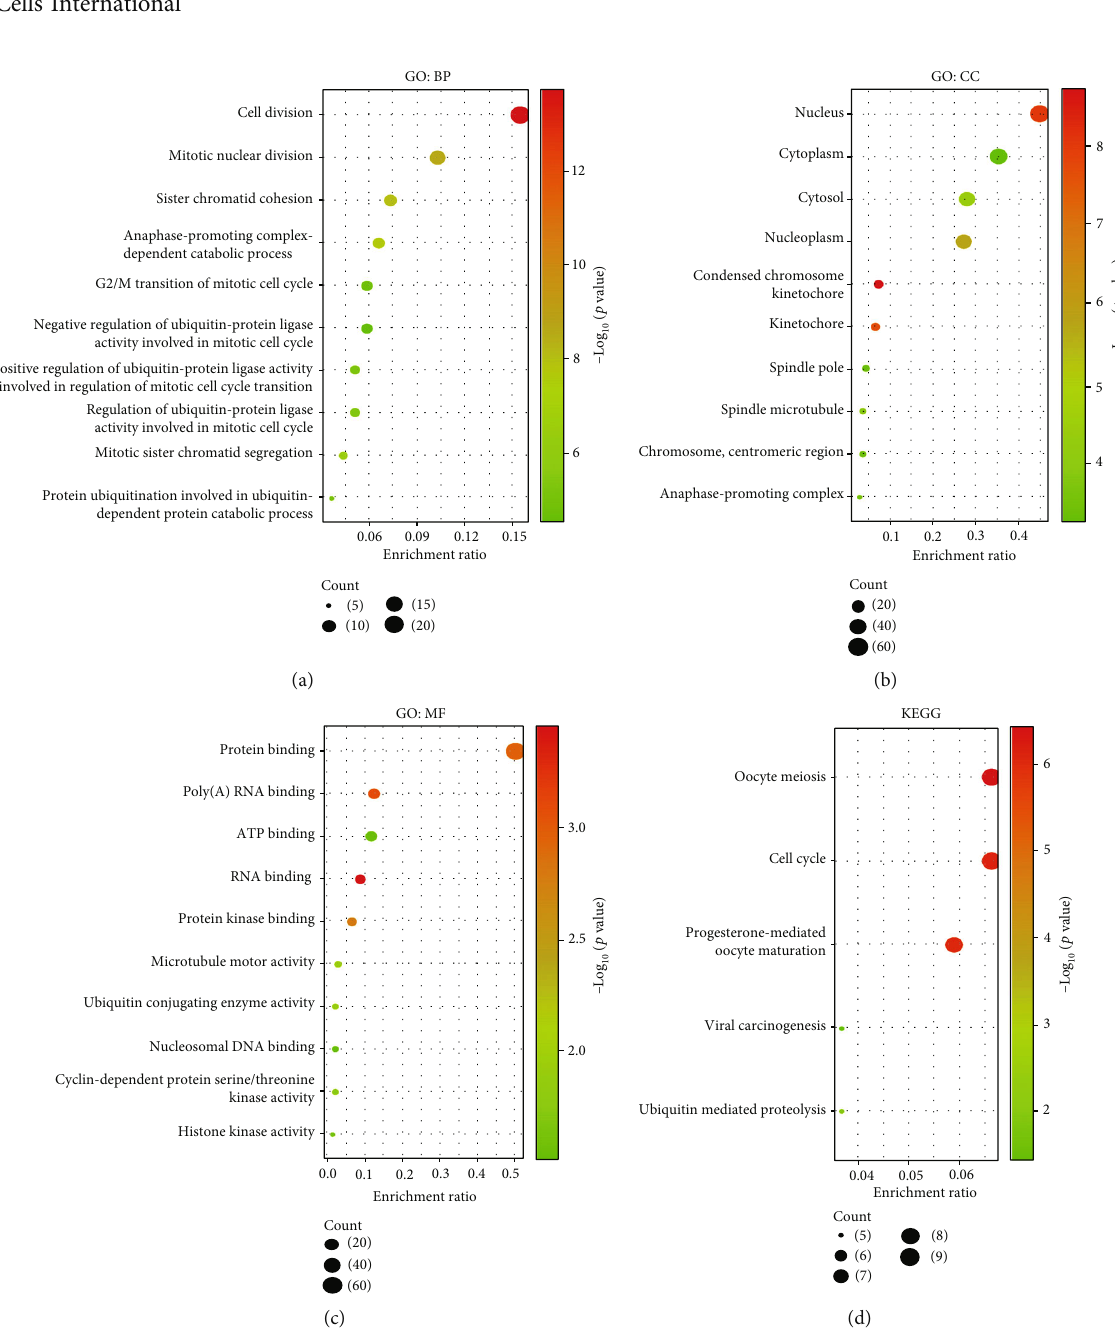
Figure 8: Patients with STAD: a functional enrichment analysis of PTTGs (DAVID). Top 10 GO term enrichment study fi ndings as a bubble graphic, broken down into biological process (a), cellular component (b), and molecular function (c). (d) Pie chart displaying the top 10 enriched KEGG pathways. Name of a GO term function or KEGG pathway ( y -axis); quantity of genes in the network that have been assigned to that word as a proportion of the total number of genes; genes with a corresponding GO term function or KEGG pathway are the “ bubble size. ” Important metabolic pathways were gleaned from gene counts and p